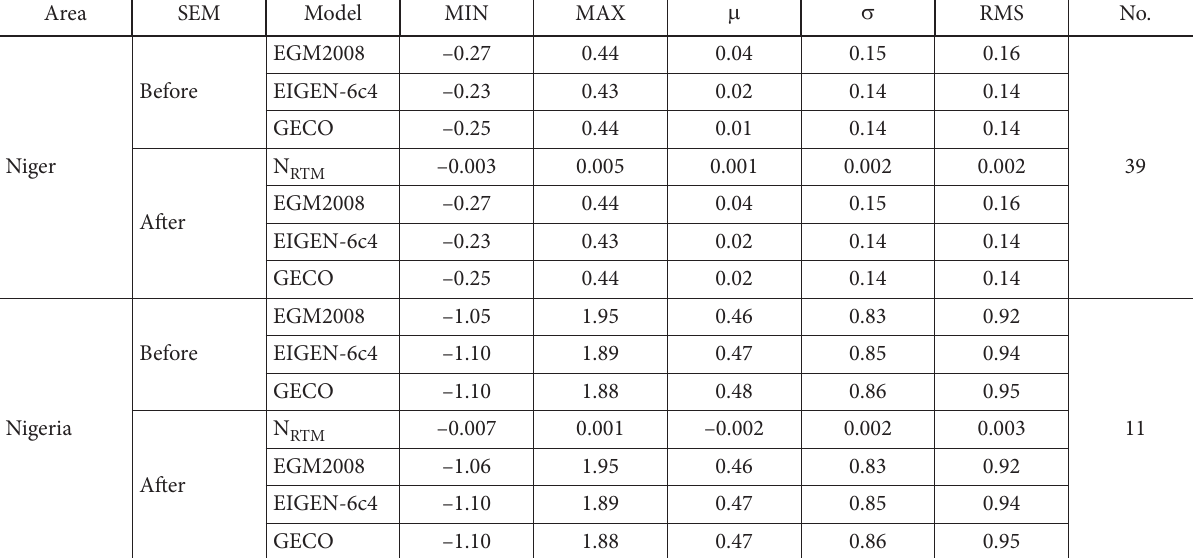
Table 3. Statistics of differences between GNSS/Levelling data and combined models at d/o 2190 (in metres)